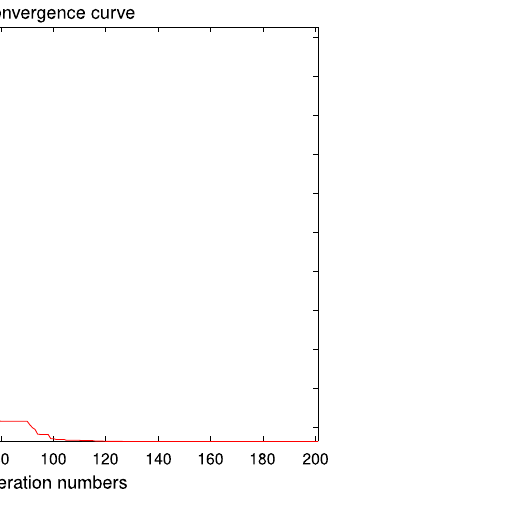
Figure 12. Convergence of cantilever